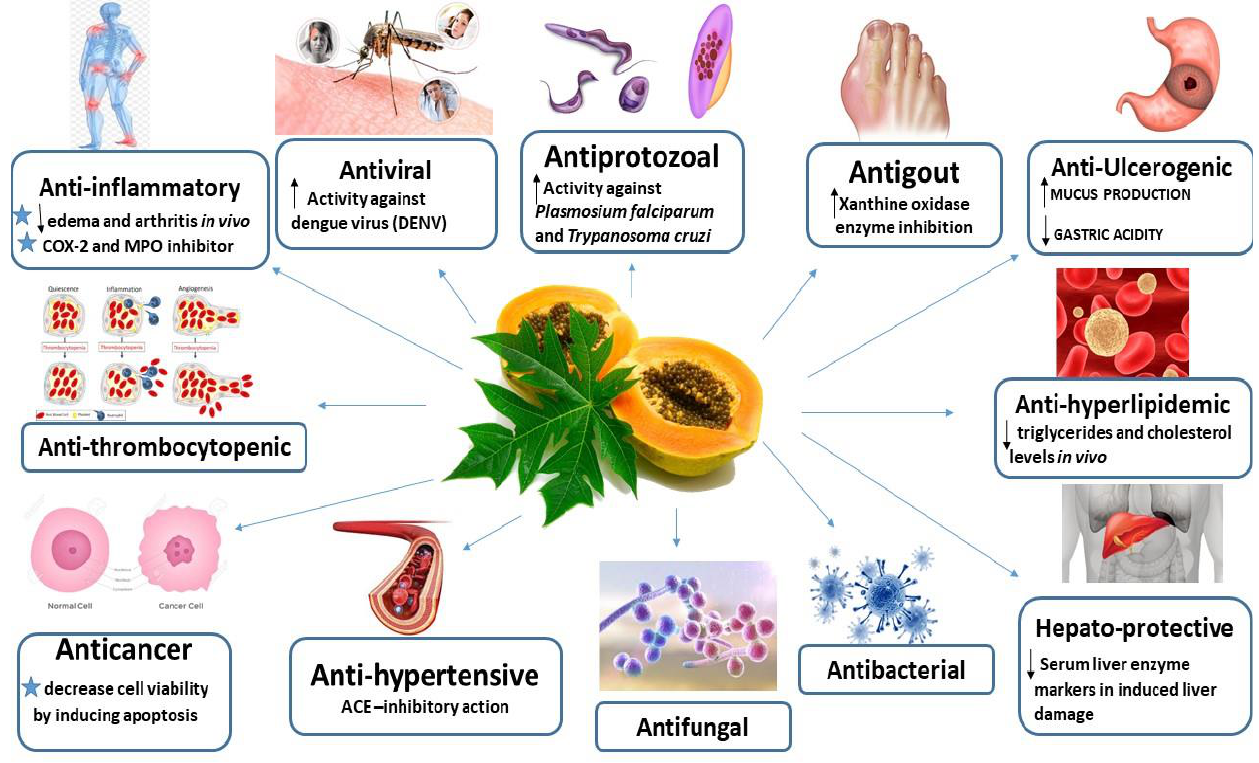
Fig. 5. Major reported biological activities of Carica